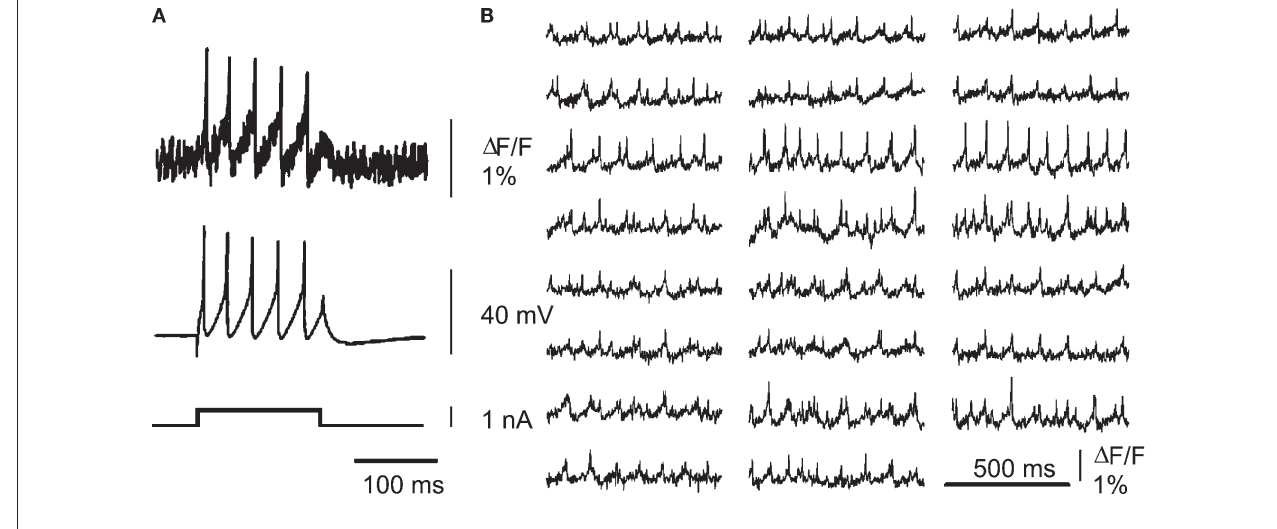
a Purkinje cell during injection of a current pulse (lower trace). (B) Simultaneous optical recording of spontaneous spiking